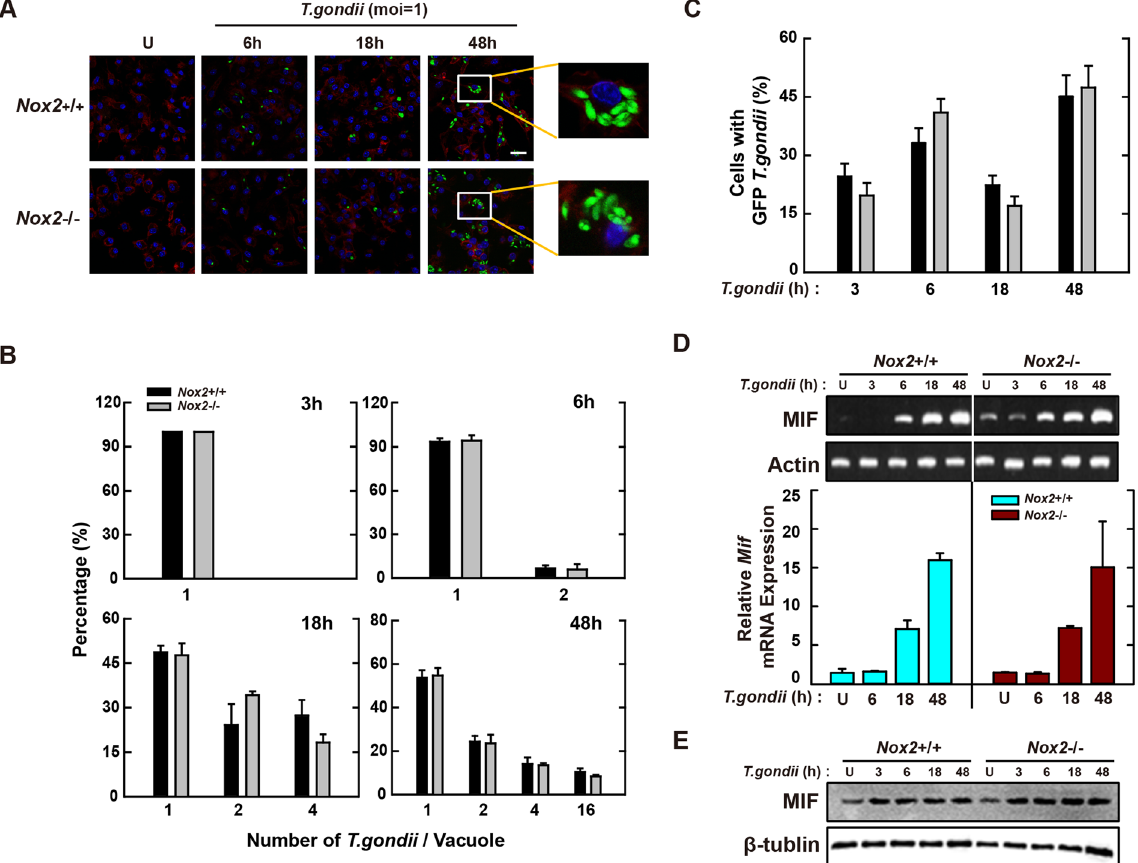
Figure 4. Macrophage-derived Nox2/gp91phox is not associated with induction of antiparasitic defense during T . gondii infection. ( A – C ) BMDMs from Nox2 + / + and Nox2 − / − mice were infected with GFP-RH strain (moi = 1) for the indicated time periods. ( A ) Cells were fixed and stained with Texas Red ® -X phalloidin for labeling F-actin (red) for cytosolic fraction, and DAPI (blue) for nuclei and then analyzed for the number of GFP-RH strain using confocal microscopy ( B , C ) The number of GFP-RH strain per vacuole (for B) or of GFP-RH strain-infected cell (for C) were analyzed. Scale bar = 25 μ m. Data are representative of five independent experiments ( D , E ) BMDMs from Nox2 + / + and Nox2 − / − mice were infected with T . gondii RH strain (moi = 1) for the indicated time periods. ( D ) The mRNA expression for Mif and actb was determined using semiquantitative RT-PCR (top) or qPCR (bottom) analysis. ( E ) Immunoblot analysis was performed to determine protein expression of MIF and β -tubulin. Data are representative of three independent experiments and are presented as means ±